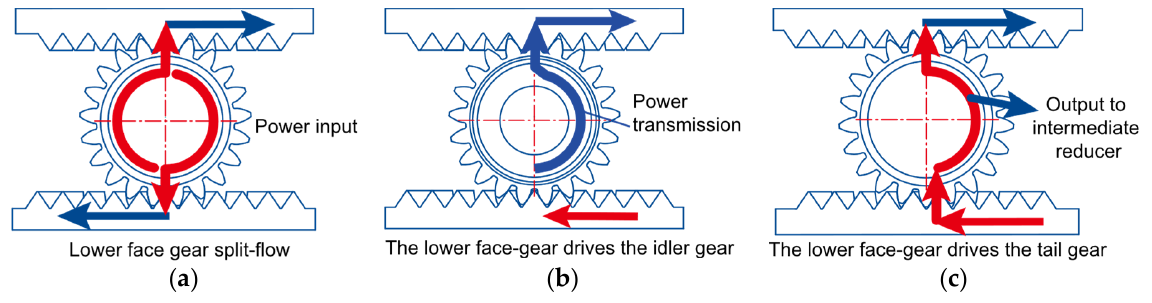
Figure 2. Power fl ow direction of CFGSTTS: ( a ) input gear; ( b ) idler gear; ( c ) tail gear .